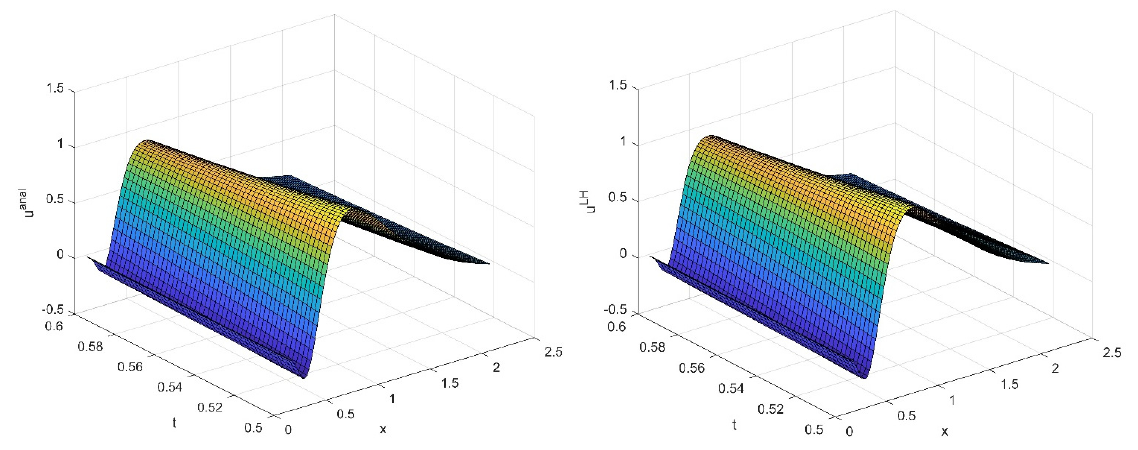
Figure 6. The concentration u as a function of x and t in the case of Experiment 1. Left side: the analytical solution. Right side: LH method for h = 0.0021.